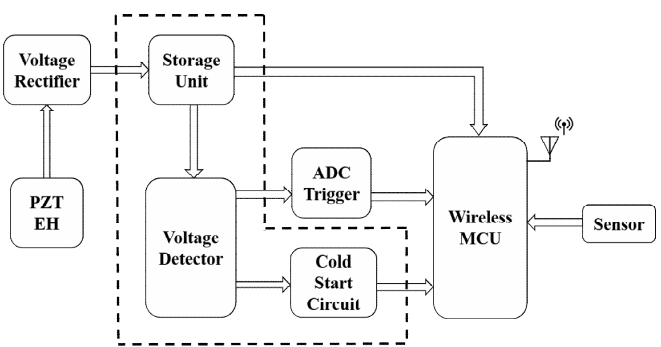
Figure 6. WSN system design architecture of a single sensor node. The arrows show the directions of different signals passing on within the system. The dashed box indicates the power conditioning module including storage unit, voltage detector, and cold start circuit.